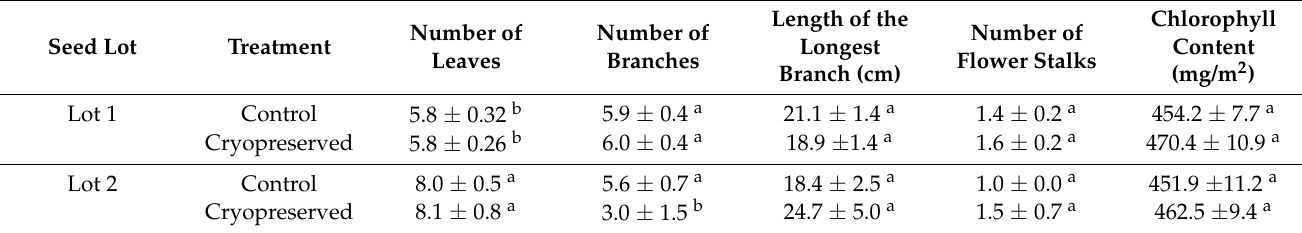
Note: Data represents mean ± standard error. Morphological traits were measured using 40 plants in each group. Chlorophyll content in leaves was estimated using four measurements from each of 10 plants per group. Means followed by different letters in columns are significantly different according to Tukey Test ( p <